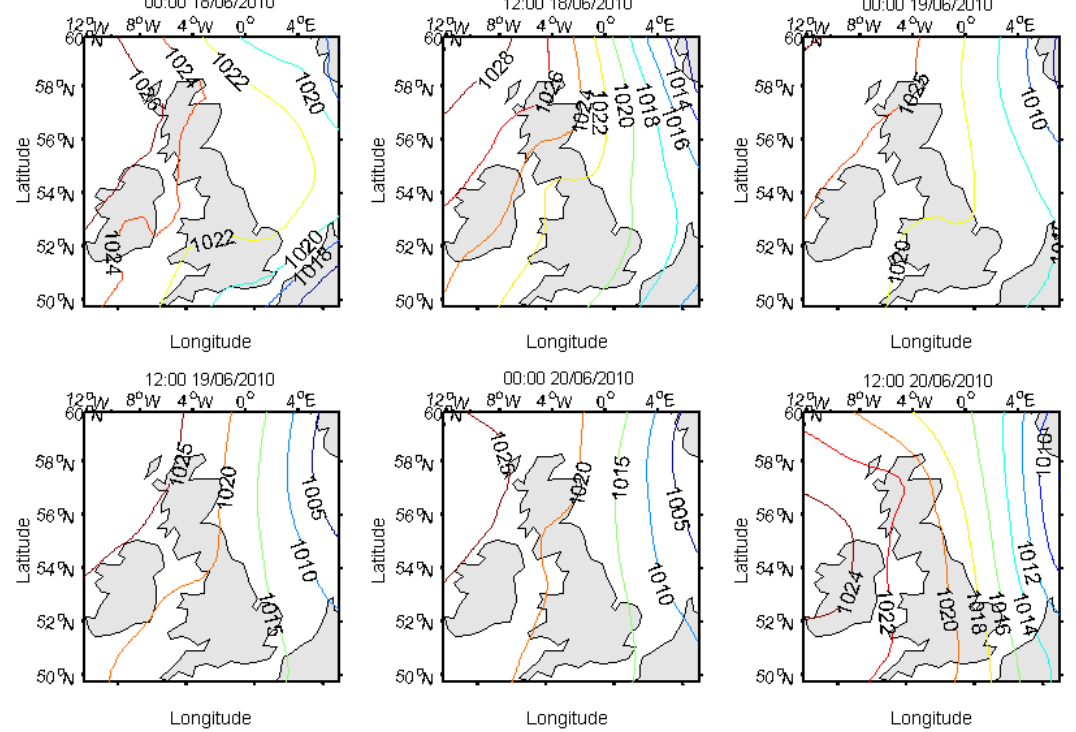
Figure 16. The mean sea level pressure fields (hPa) before and during the 19 June 2010